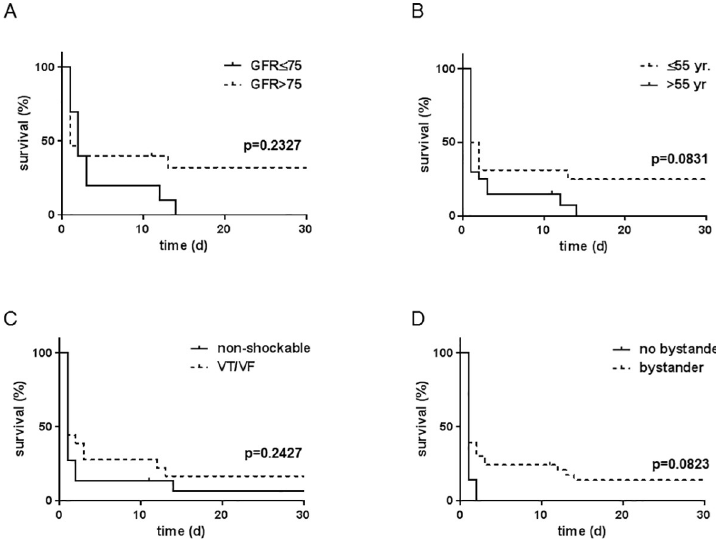
Fig 1. Survival following extracorporeal cardiopulmonary resuscitation (eCPR). 30-day survival on eCPR depending on admission renal function (A), age (B), presence of shockable rhythm (C) or bystander CPR (D).